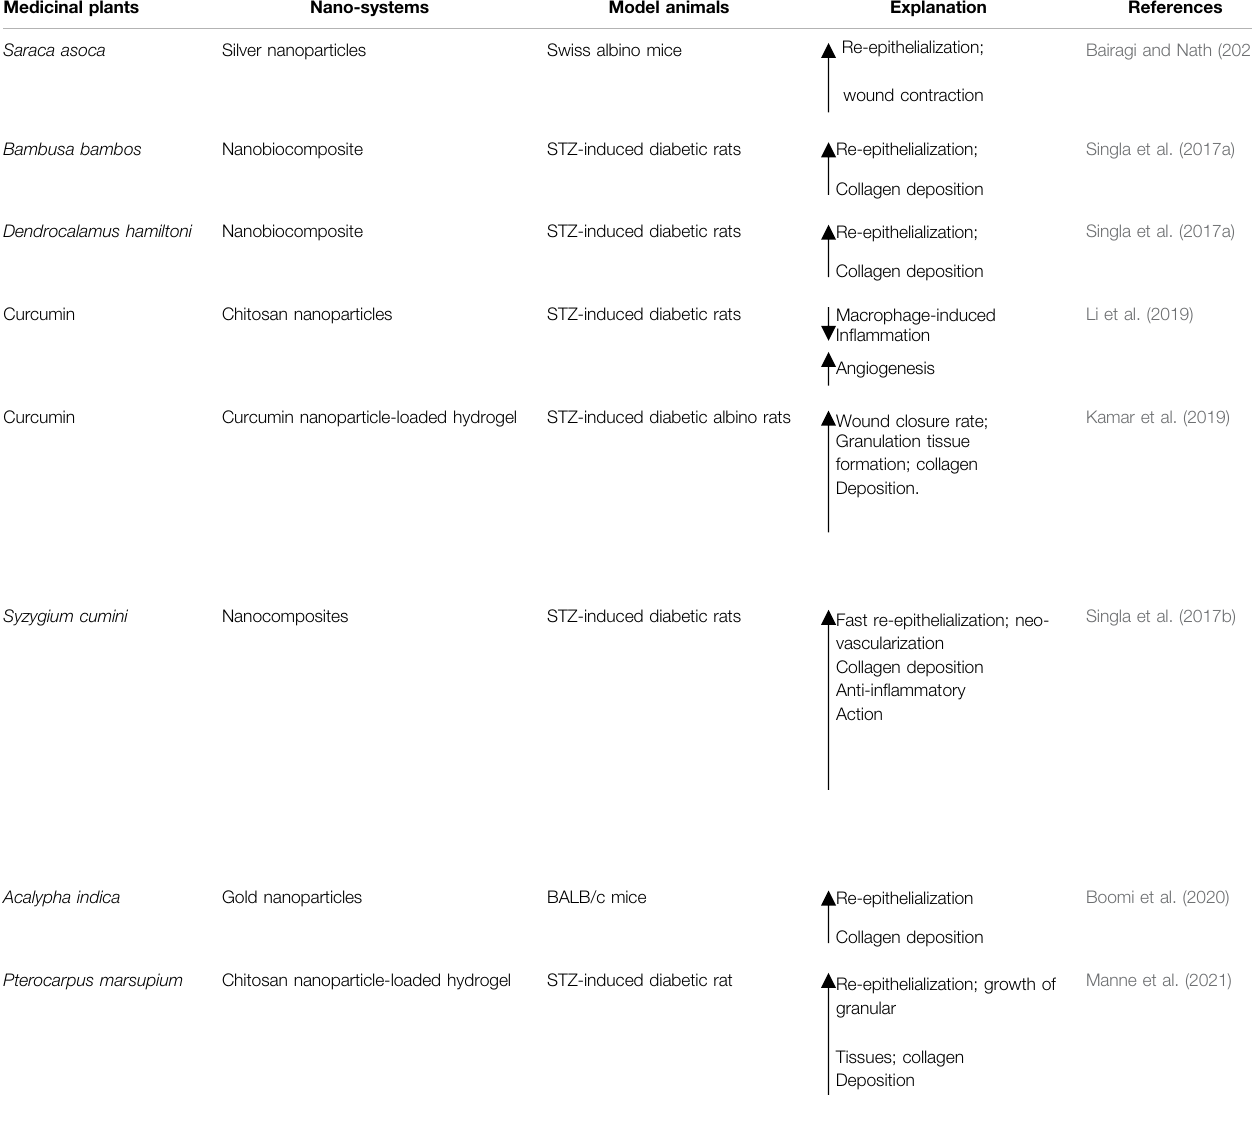
TABLE 2 | Nanoformulations for diabetic wound healing. Medicinal